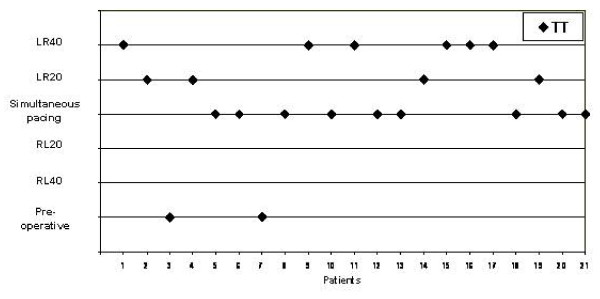
The best VV-interval after optimization in each patient in this study (n = 21). With sequential pacing greatest longitudinal motion measured by tissue tracking (TT) was reached in 12 patients (57%).